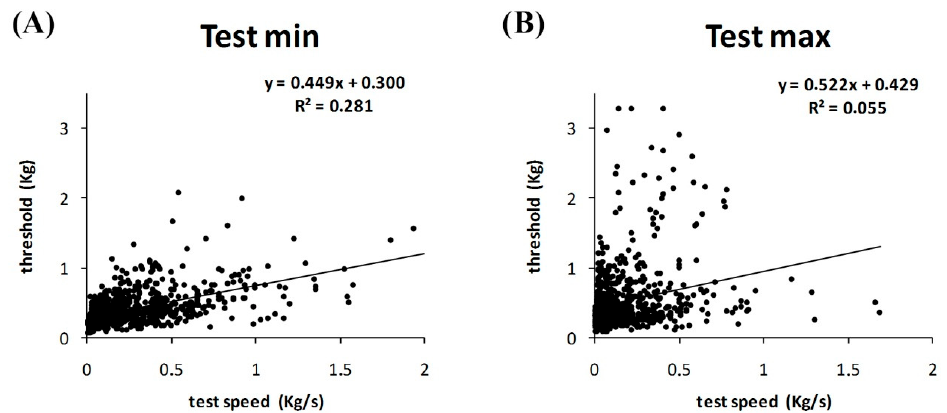
Figure 2. Correlation between speed test and pain threshold. ( A ) A positive correlation is shown between pain threshold and test speed in minimal tests; ( B ) this correlation is lower in maximal tests.